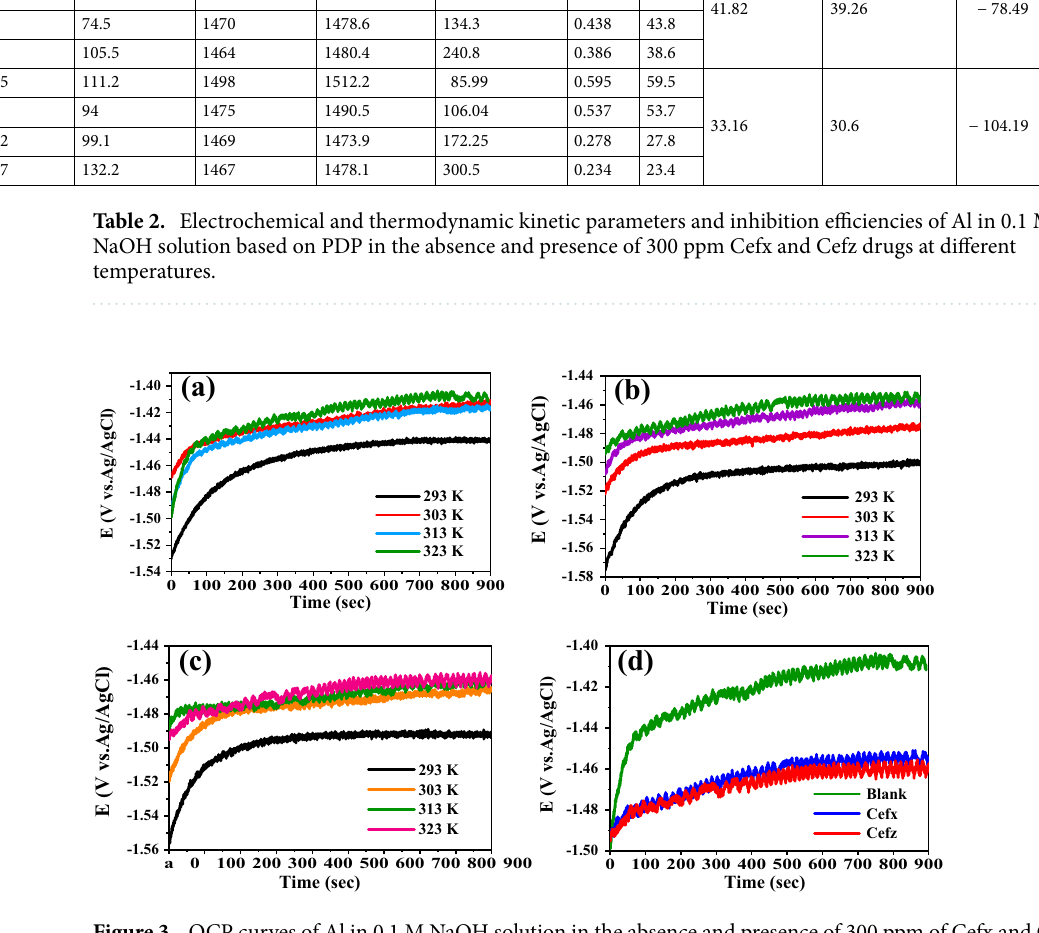
the absence and existence of various concentrations (50–300 ppm) of Cefx and Cefz at 293 K with a sweep rate of 1 mV/s. Table 1 lists the electrochemical polarization characteristics, including corrosion potentials ( E corr ), cor- rosion current densities ( i corr ), anodic Tafel slopes ( β a) and cathodic Tafel slopes ( β c). The inhibition efficiencies ( η %) are obtained using the equation below 42,43 .